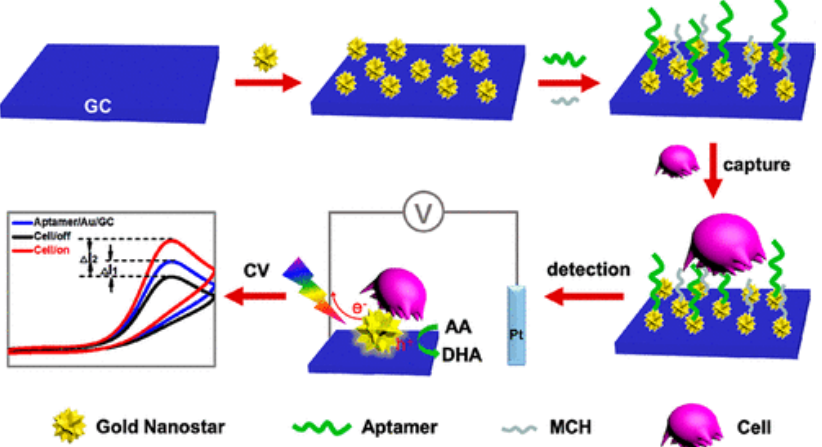
Figure 6. Schematic diagram of the cell-based biosensor developed by Wang. Reproduced with permission from [62], American Chemical Society, 2019.